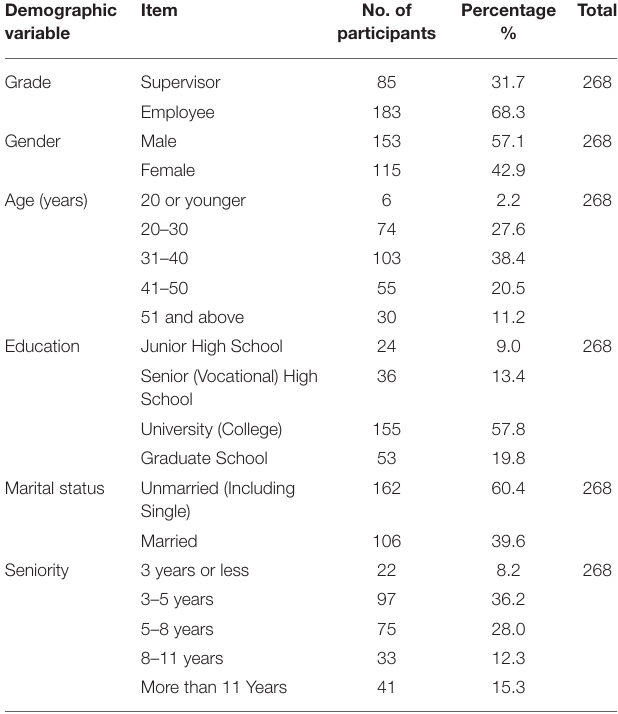
TABLE 1 | Sample structure.